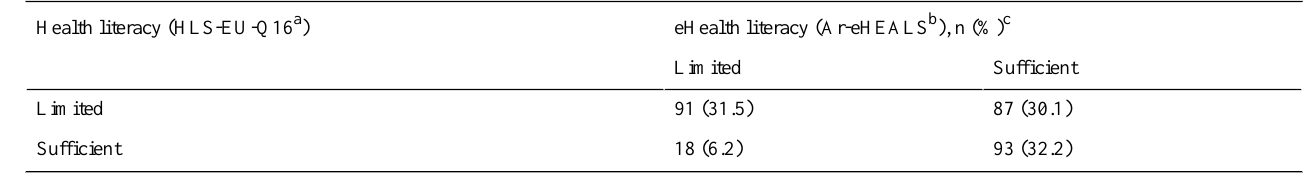
Table 5. Distribution of participants scoring sufficient resp. limited health literacy and e-health literacy and participants scoring different levels depending on which